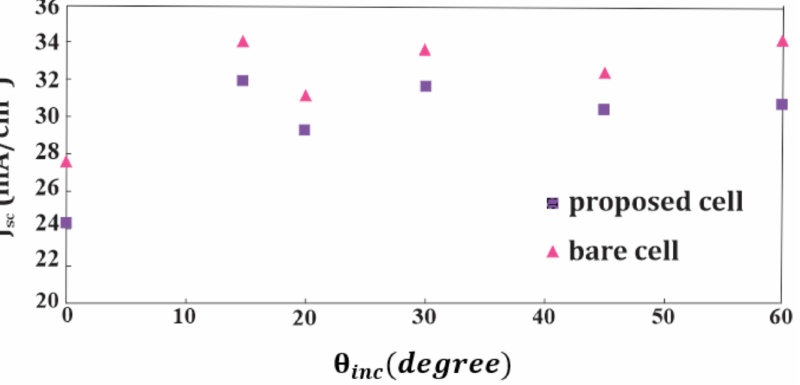
Figure 13. The short circuit current density (in mA/cm 2 ) of the bare and proposed cell of InP NW array solar cell for varying radiation